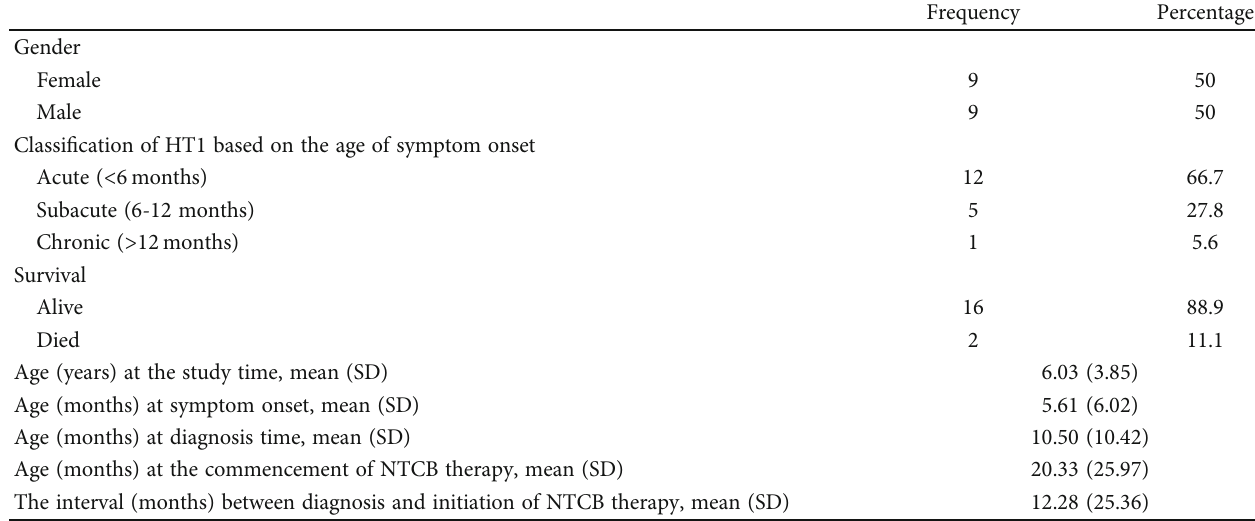
Table 1: Descriptive analysis of the HT1 sociodemographic characteristics.